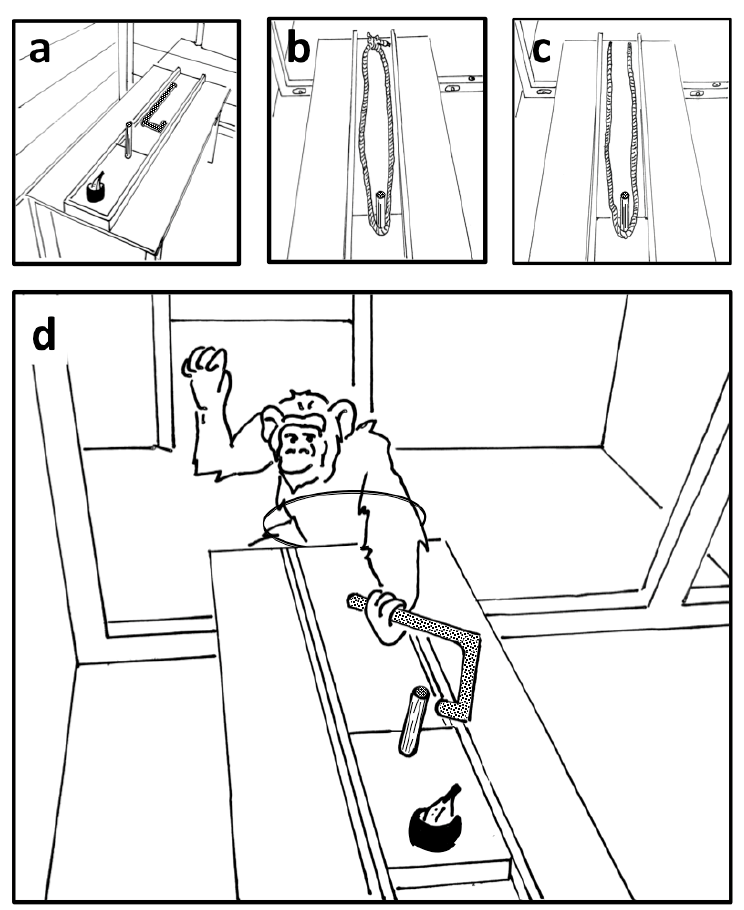
Testing Configurations for the (a) Hook, (b) Loop and (c) Untied Conditions, and (d) Megan Using the Hook Tool to Retrieve the Sliding Block by Placing the Crooked End around the